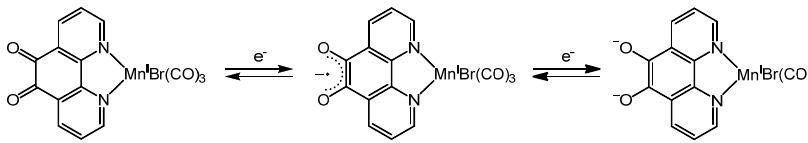
Scheme 3. Two successive one-electron reductions of the dpq ligand under aprotic conditions.